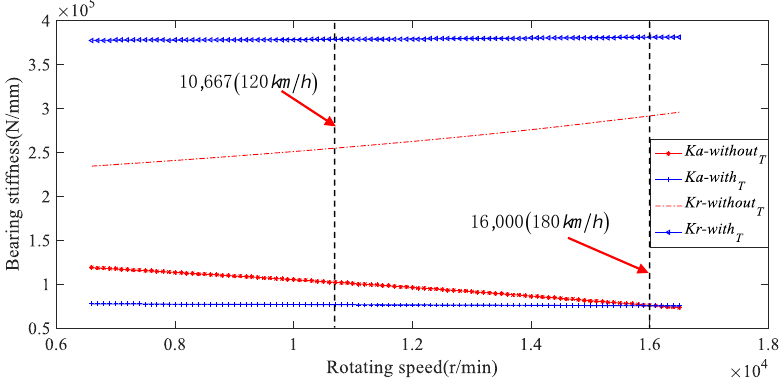
Figure 11. Axial and radial stiffness of the bearing with or without the thermal deformation.